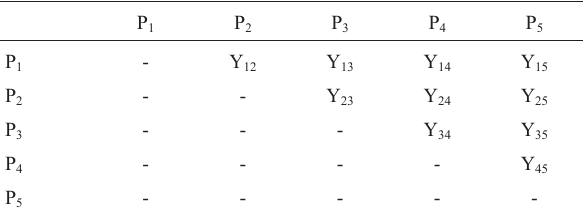
Table 3 - Diallelic table with 5 parents (Pi, i = 1, 2, ...5) and their F1